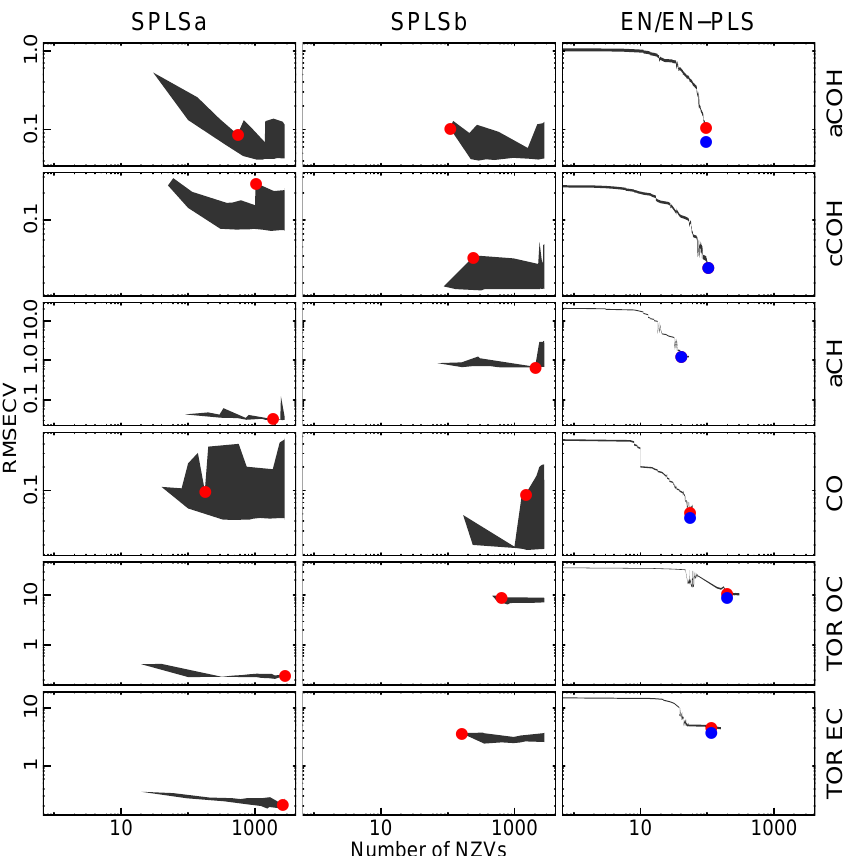
Figure 1. Estimated RMSECVs for a range of models using a different subset of wavenumbers are shown by shaded regions. Results are shown for models using raw spectra. For panels in the first two columns (SPLSa and SPLSb), the shaded regions extend from the minimum RMSECV to pRMSECV solutions for each sparsity penalization parameter. For the last column of panels (EN/EN–PLS), the shaded region extends from the minimum RMSECV to 1 standard error above for each value of the penalization parameter in EN estimates. Circles correspond to models selected for this work. For EN/EN–PLS panels, red circles correspond to the EN solution, and blue circles correspond to the selected solutions for EN–PLS. The RMSECVs for EN–PLS are underestimated (Appendix C) and may not be amenable for direct comparisons with other